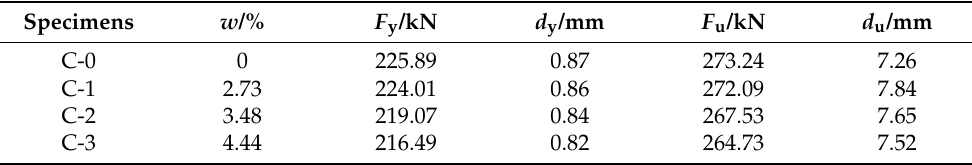
Table 6. Results of the tensile properties of the corroded bolt-sphere connections.